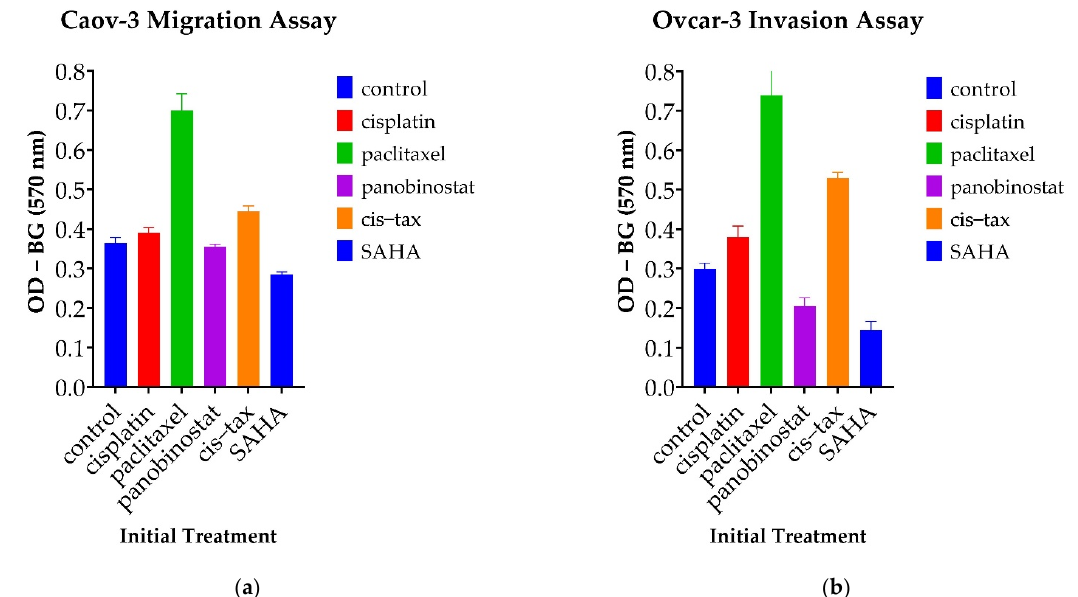
Figure 10. Changes in migration and invasion capacity in spheroid-derived cells following their initial treatment in a 3D system. Surprisingly, cells from both lines exposed to paclitaxel demonstrated a greater ability to migrate and invade than the control. Optical density was measured at 570 nm minus the background. ( a ) Pretreated Caov-3 cells from spheroids were replated over migration assays. Cells treated with epigenetic therapy had diminished propensity for migration, although these did not reach statistical significance. ( b ) Pretreated Ovcar-3 cells from spheroids were replated over invasion assays. Again, epigenetic therapy appeared to thwart the invasion capability of these cells, although they did not reach statistical significance ( n = 2).